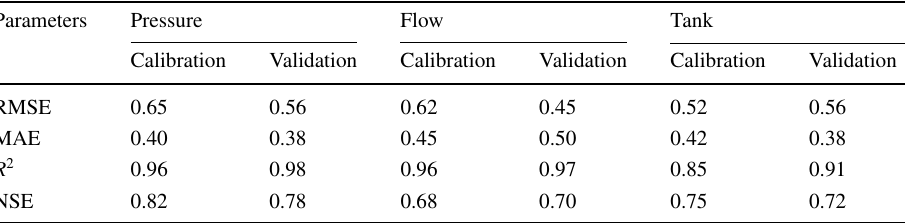
evaluation of pressure, flow, and tank level in both the model calibration and validation